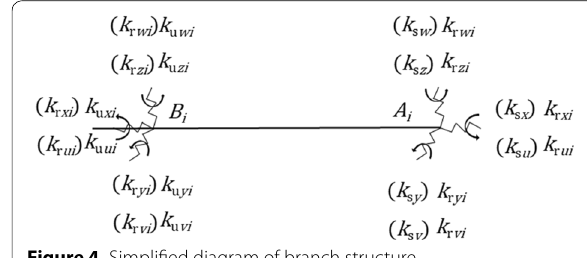
Figure 4 Simplified diagram of branch